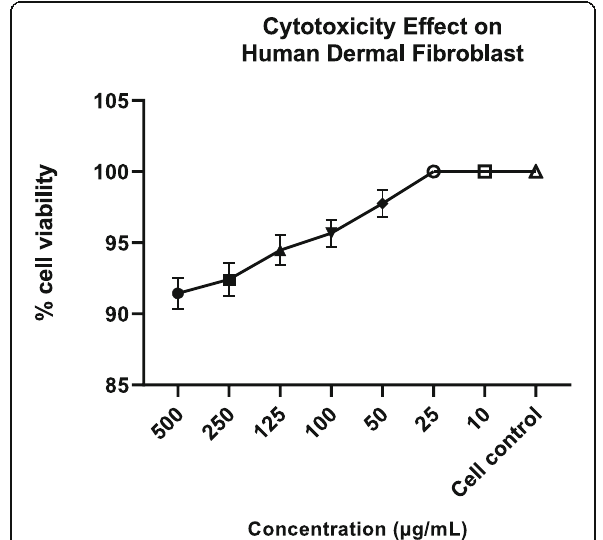
Fig. 7 Cytotoxicity effect of root extracts of S. heyneanus on human dermal fibroblast cells. Cell control represents sample without the addition of any extract. Statistical significance — t = 13.065 and p value =